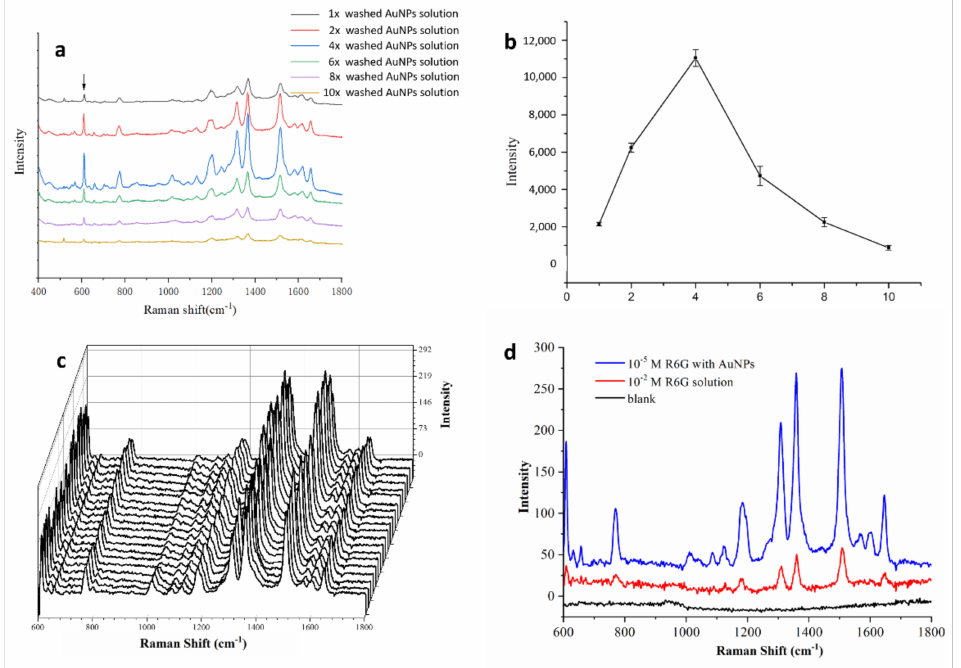
Figure 4. ( a ) Raman spectra of 10 − 5 M R6G in the coffee ring with 1 × , 2 × , 4 × , 6 × , 8 × and 10 × concentration water-washed Au NP colloids. ( b )The tendency of Raman intensity of 10 − 5 M R6G in the coffee ring with water-washed Au NP colloids with different concentration times based on the peak of 1364 cm − 1 . Data in a and b were collected from the Laser Raman spectrometer (Renishaw, UK): excitation wavelength, 785 nm; maximum excitation power, 5 mw; integration time, 10 s. ( c ) SERS intensity of 10 − 5 M R6G in the coffee ring measured in air, using laser excitation at 780 nm and 80 mW. ( d ) SERS intensity of 10 − 5 M R6G in the coffee ring, 10 − 2 M R6G solution and blank. Data in c and d were collected from the DXR Smart Raman spectrometer (Thermo Fisher Scientific, Waltham, MS, USA): excitation wavelength, 780 nm; maximum excitation power, 80 mw; integration time, 15